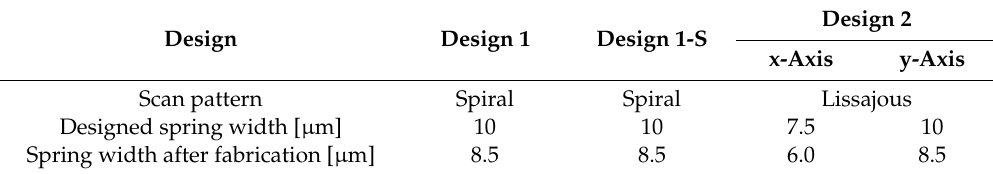
Figure 1. Schematic of the presented aluminum nitride (AlN) micromirror designs. Table 1. Overview of the designed spring widths in comparison to the resulting spring widths after fabrication. The target thickness of the device Si was 20 µm.